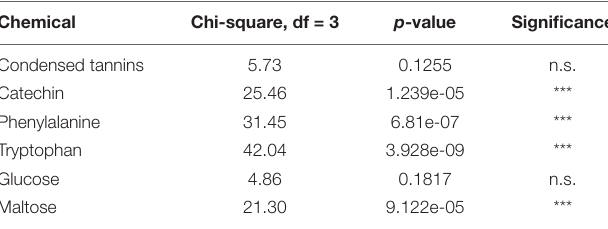
TABLE 1 | Summary of Kruskal–Wallis statistics on treatment effects as presented in Figure 2